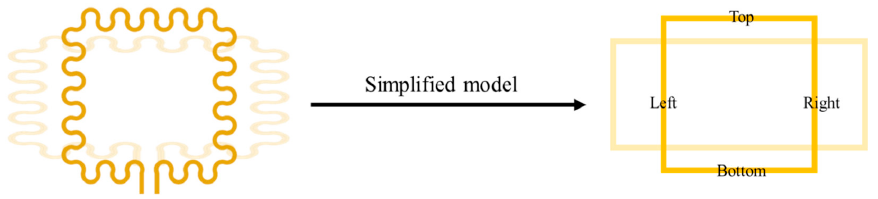
Figure 4. Simplification of the serpentine sensor coil as a rectangle to calculate the